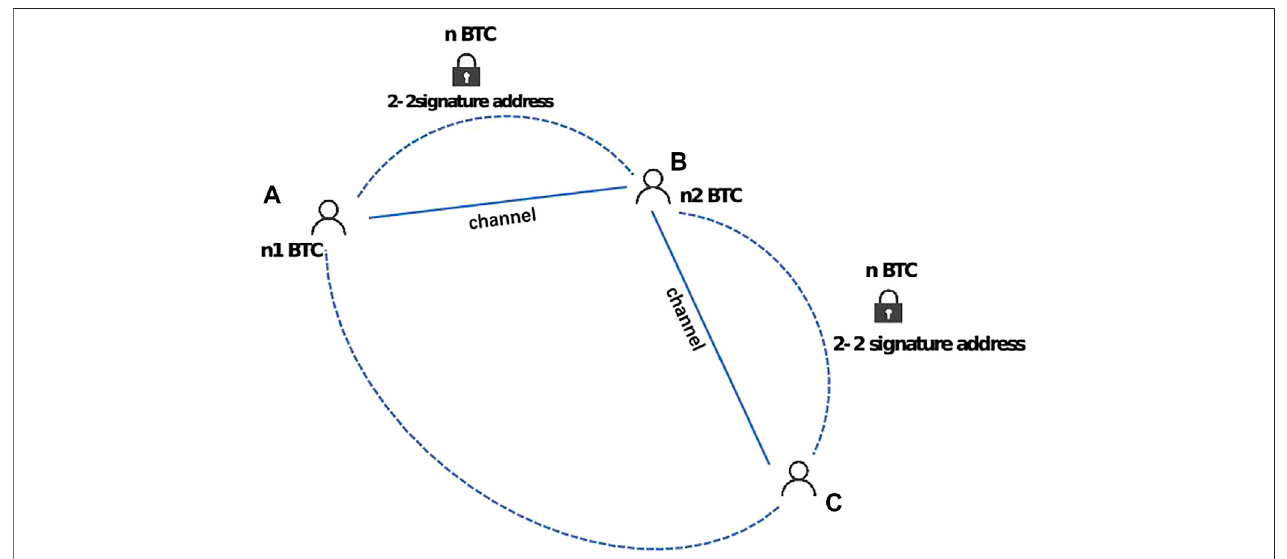
FIGURE 1 | Illustration of payment channel network. A and B can jointly contribute n bitcoins to establish a channel, and when they need to trade, they can do so through the channel. And when there is no channel between A and C, the transaction can be done through